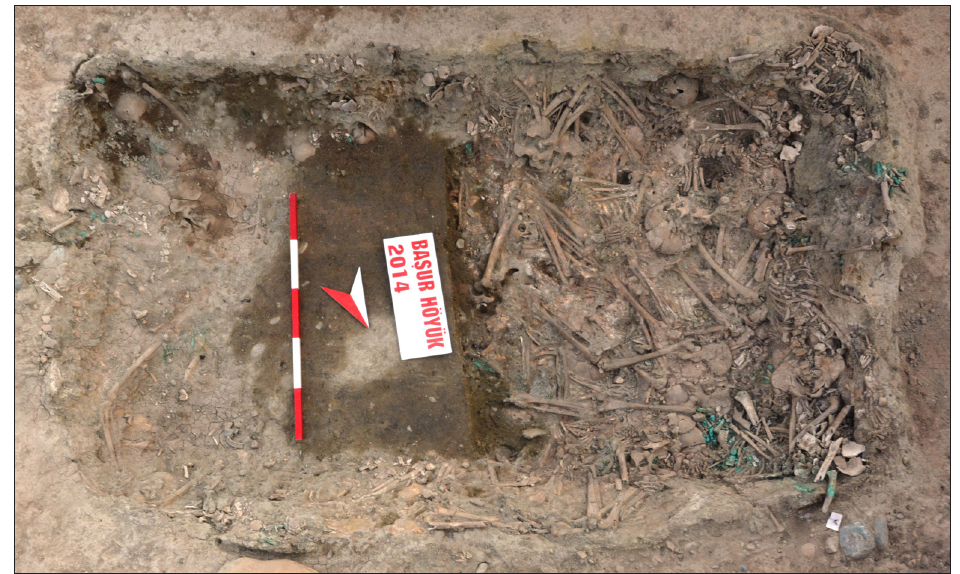
Figure 2: The mass death pit, which is central to new investigations of the use and function of radical death practices in the formation of early states as part of the Radical Death Project. Ranging pole is 2.5 m, arrow is to North. Figure: Ba